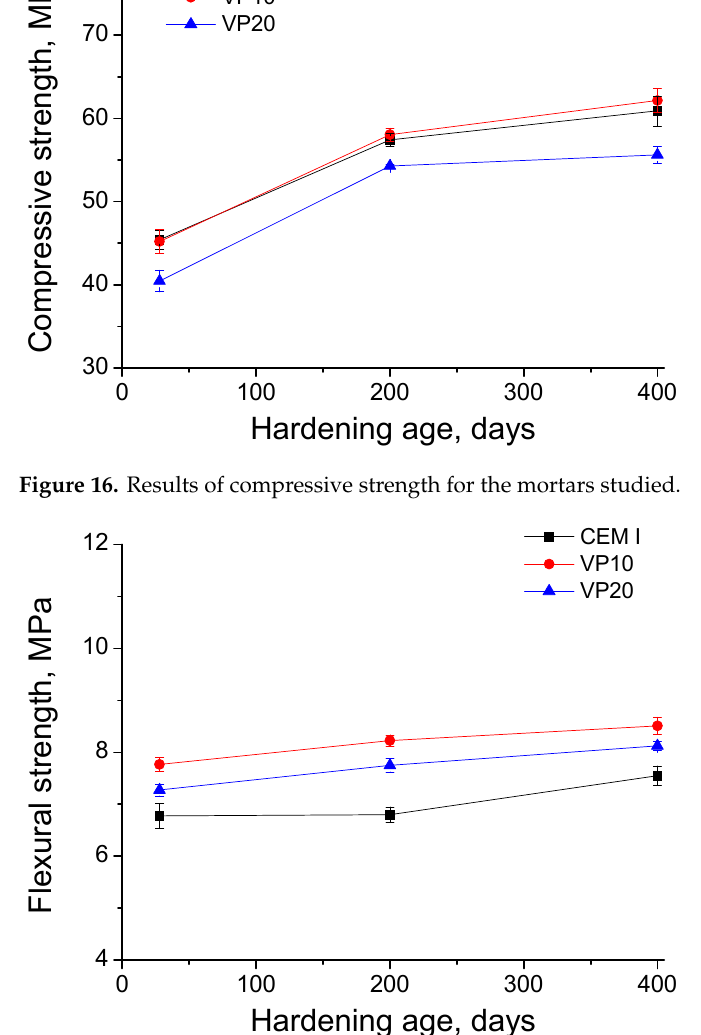
Figure 17. Results of flexural strength for the mortars studied.